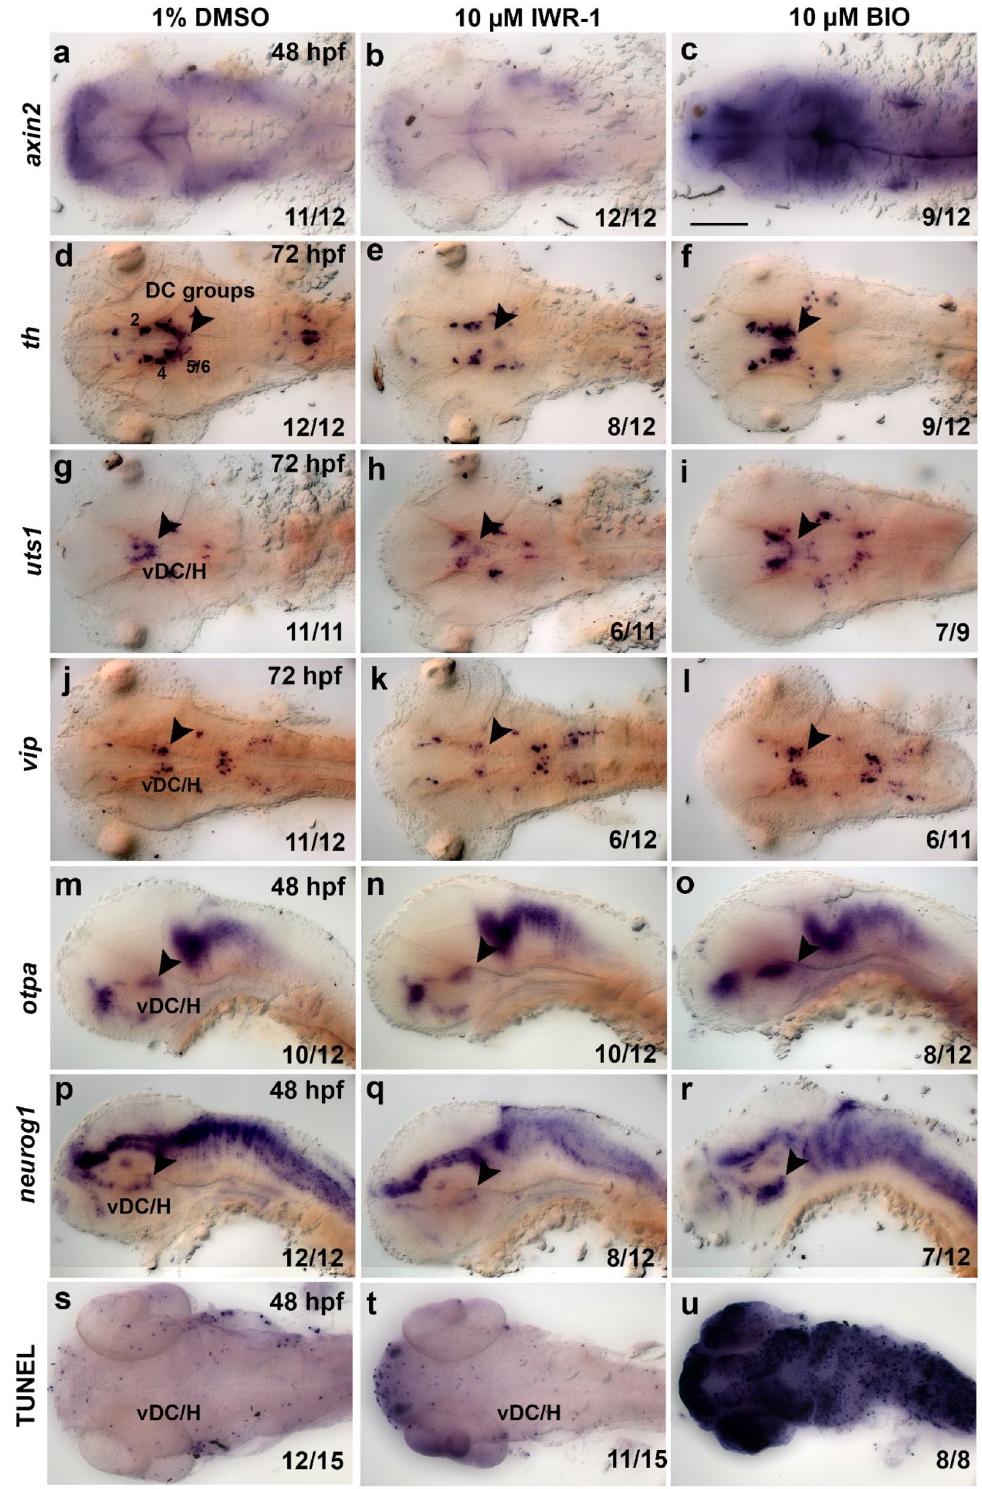
Figure 5. Pharmacological inhibition and activation of Wnt/β-catenin signaling affect neurogenesis of hypothalamic neurons. ( a – r ) Expression analysis of axin2 ( a – c ), th ( d – f ), uts1 ( g – i ), vip ( j – l ), otpa ( m – o ) and neurog1 ( p – r ) by whole mount in situ hybridization and detection of cell death by the TUNEL assay ( s – u ) in embryos treated with DMSO (control), IWR-1 or BIO as indicated at top. All embryos were treated from 18 to 42 hpf and fixed at stages indicated in left column of image panels. ( a – l ) Dorsal and ( m – r ) lateral views of larval heads, images are Z-projections of image stacks. The arrowheads point to differences in marker gene expression within the ventral diencephalon and hypothalamus. Scale bar in ( c ) is 100 µm for all images. Numbers N/N in bottom right corner of each image indicate number of representative phenotypes as shown in image versus total embryos analyzed for this condition. H hypothalamus, vDC ventral